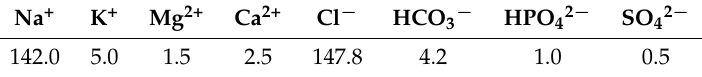
Table 1. Composition of the simulated body fluid, in mM, prepared for the in vitro